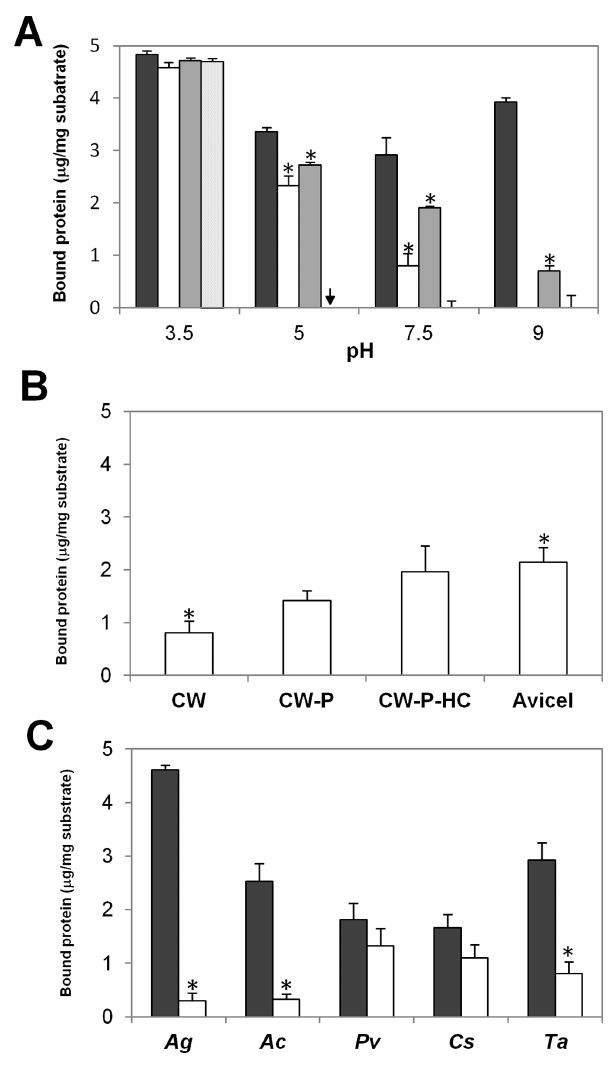
Figure 3. PcExl1 and BsEXLX1 bind differently to whole plant cell walls. (a) pH influence on binding of expansins (BsEXLX1, dark grey; PcExl1, white; D82A, black; YWY, dotted) to wheat coleoptile cell walls. The arrow indicates that YWY mutant was unstable at pH 5 in citrate buffer, and only a protein smear was detected, impeding quantification. *Significant differences at the different pHs ( p , 0.01, Fisher’s LSD test). (b) Binding of PcExl1 to wheat coleoptiles whole cell walls (CW), or cell wall fractions after extraction of polysaccharides: pectin-depleted (CW-P), and pectin- and hemicellulose-depleted (CW-P- HC), or Avicel. *Significant differences ( p , 0.05, Fisher’s LSD test). (c) Binding of expansins (BsEXLX1, dark grey; PcExl1, white) to cell walls from different plant species: Apium greveolens ( Ag ), Allium cepa ( Ac ), Phaseolus vulgaris ( Pv ), Cucumis sativus ( Cs ), and Triticum aestivum ( Ta ). In all cases, 5 m g of protein were incubated with 1 mg of substrate for one hour at 1000 rpm and 25 u C. Results are the arithmetic mean and standard error of at least three independent experiments. * Significant differences between PcExl1 and BsEXLX1 binding to the same plant species ( p , 0.05, Fisher’s LSD